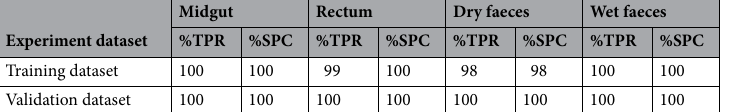
Table 1. Sensitivity and specificity of the T. cruzi training models. Predicted sensitivity [true positive rate (TPR)] and specificity (SPC) of NIRS are shown for samples used in the training set for midgut (n = 100), rectum (n = 100), dry faeces (n = 100) and wet faeces (n = 100) and samples that were excluded from the training set (validation set) for the same groups (n = 74, 74, 58 and 58,